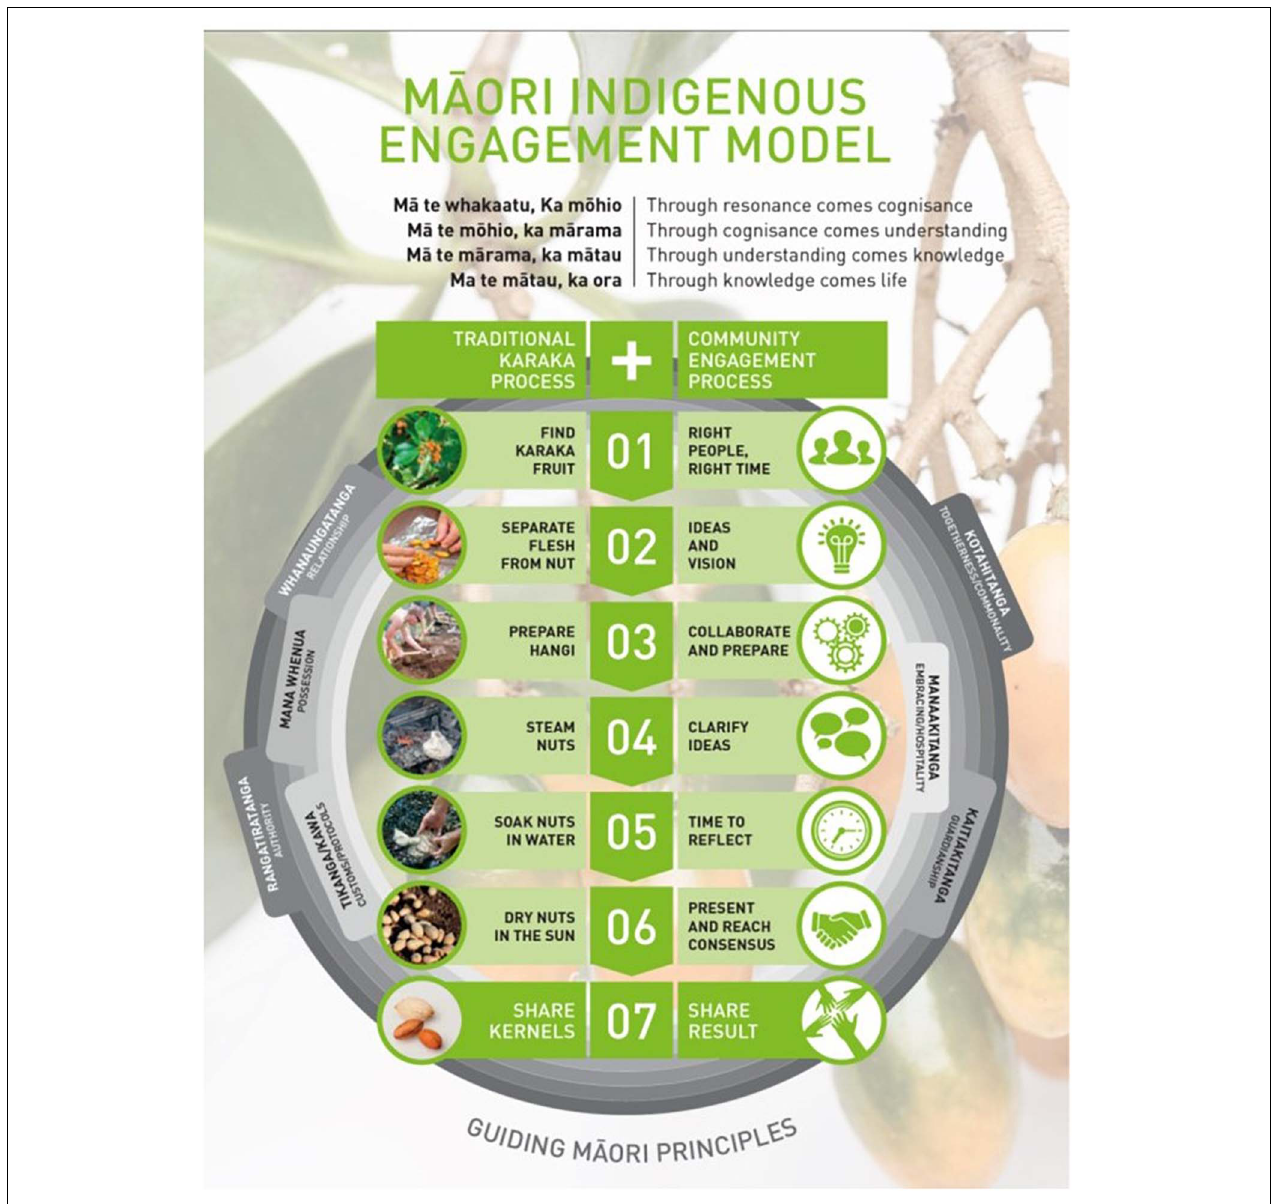
FIGURE 1 | M¯aori indigenous engagement model developed as a framework of how to engage and work with M¯aori. The framework is based on the traditional M¯aori process of removing toxins from karaka (Corynocarpus laevigatus) kernals prior to eating, as a model for successful engagement. If one step is missed, the toxins will not be removed from the resulting kernals; similarly, if we take short cuts in the engagement process then we will not remove all doubt and suspicion. This framework was developed by Alby Marsh, Jenny Green, Hone Ropata, Bob Fullerton (The New Zealand Institute for Plant and Food Research Limited) and Matua Grant Hawke (Ngati Whatua Ki